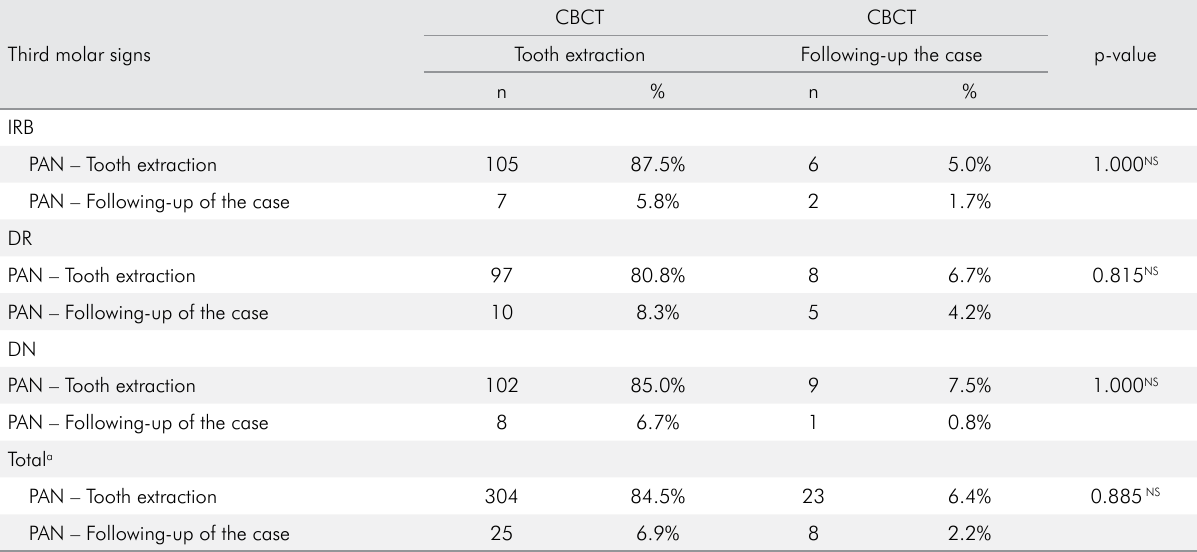
Table 5. Scores chosen in response to the question “Which treatment option would you choose?” before (PAN) and after CBCT. Third molar signs